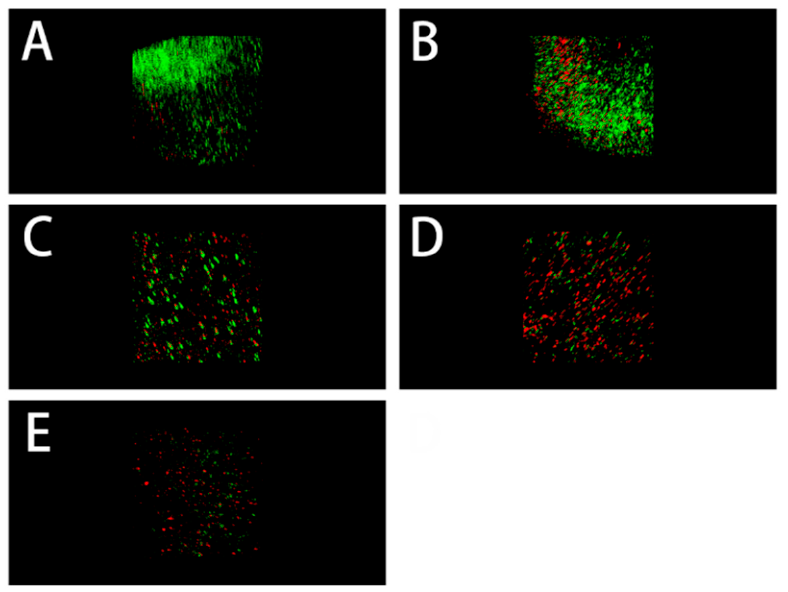
Figure 7. Representative CLSM images of E. faecalis biofilms in dentin tubules of different treatments, ( A ): DW; ( B ): EDC; ( C ): 1 mg/mL TMC + EDC; ( D ): 5 mg/mL TMC + EDC; ( E ): 10 mg/mL TMC + EDC.